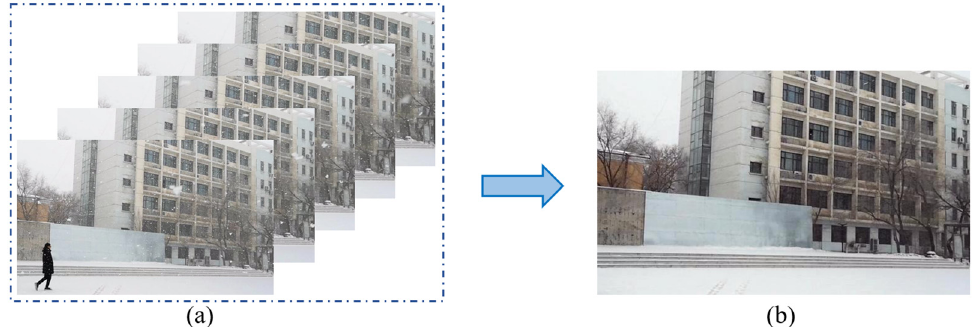
Figure 2. Extracting the low-rank background ( b ) from a snow video sequence ( a